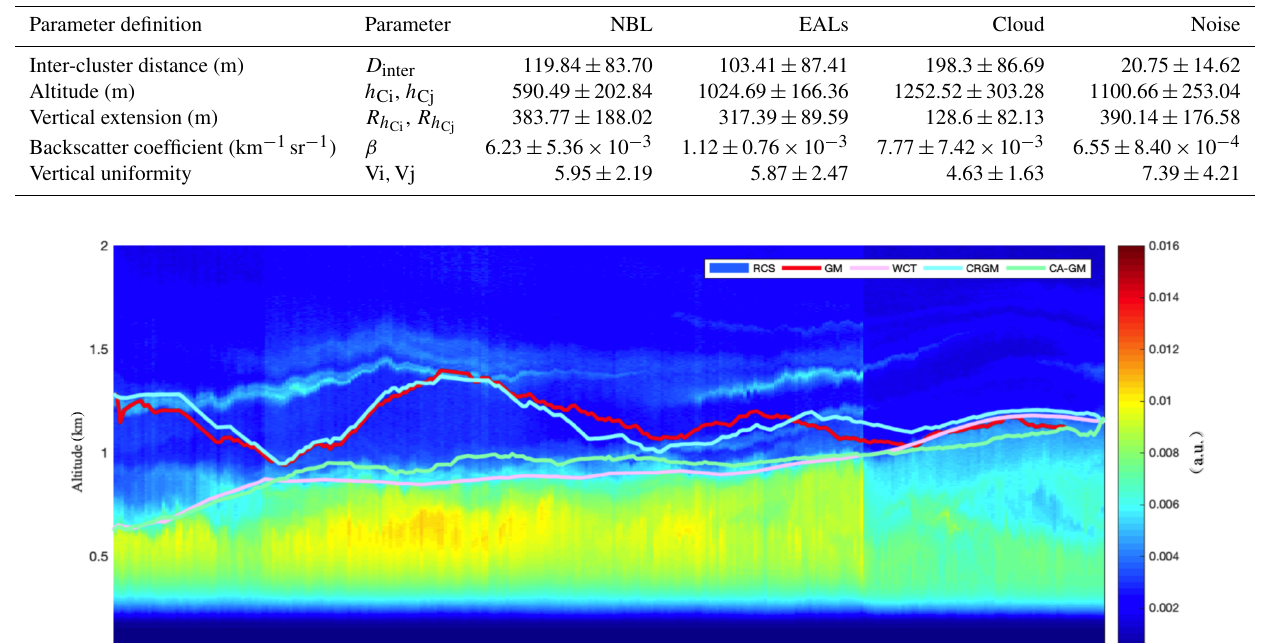
Table 3. Computed criteria parameters for layer attribution.